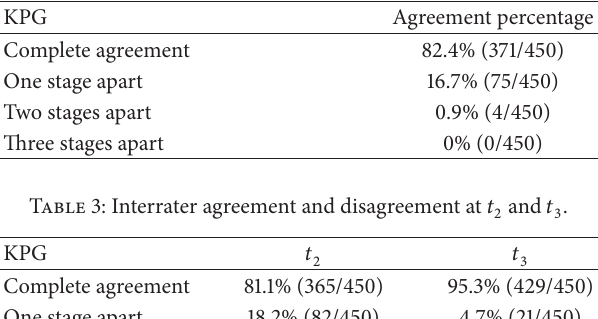
Table 2: Intrarater agreement and disagreement between 𝑡 2 and 𝑡 3 .